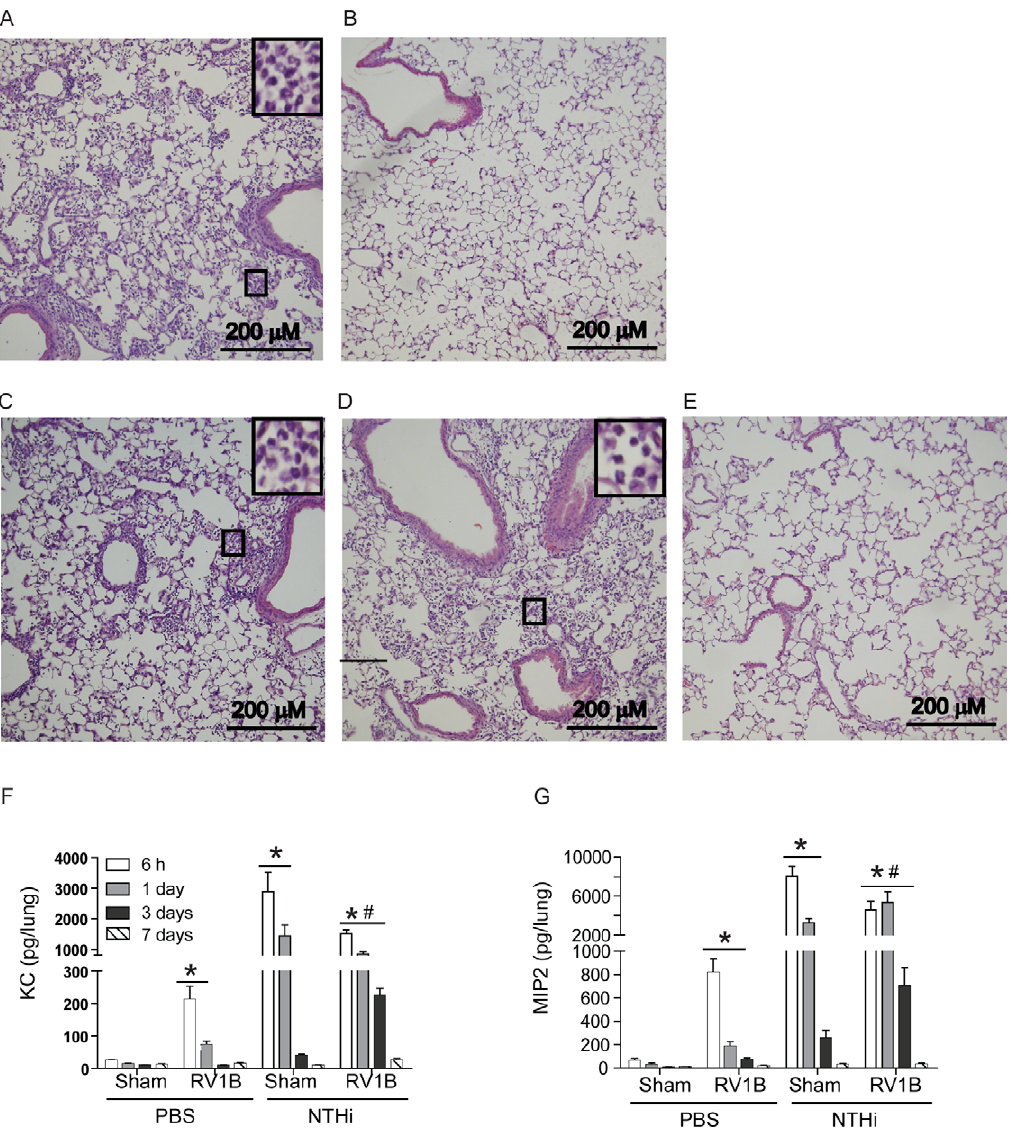
Figure 2. RV infection prolongs lung inflammation caused by NTHi and suppresses initial chemokine response. Mice were infected with sham or RV followed by NTHi as described in Figure 1. (A and B) Hematoxylin and eosin stained lung sections from Sham/NTHi-infected mice at 1 and 3 days post NTHi infection respectively. (C to E) Hematoxylin and eosin stained lung sections from RV1B/NTHi-infected mice at 1, 3 and 7 days post NTHi infection respectively. Inserts in the top left corners of A, C and D are magnified view of area marked in respective panels showing neutrophils. (Fand G) Chemokine levels in lung homogenate supernatants were determined by ELISA. Images in A to E are representative of 3 to 4 animals per group. Data in F and G represent mean 6 SD (n=4–9, * p # 0.05, two-way ANOVA, different from sham; # p # 0.05, two-way f ANOVA, different from sham/NTHi infected animals).